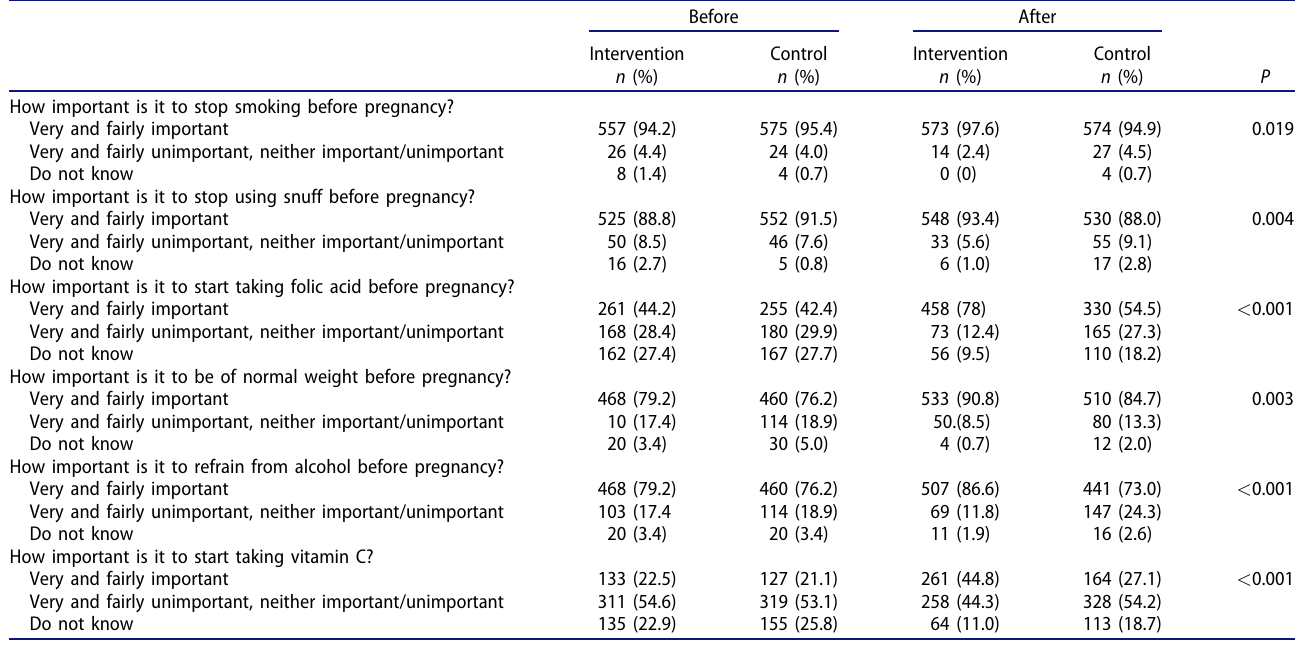
Table 4. Women ’ s awareness of preconception health before and after the intervention.